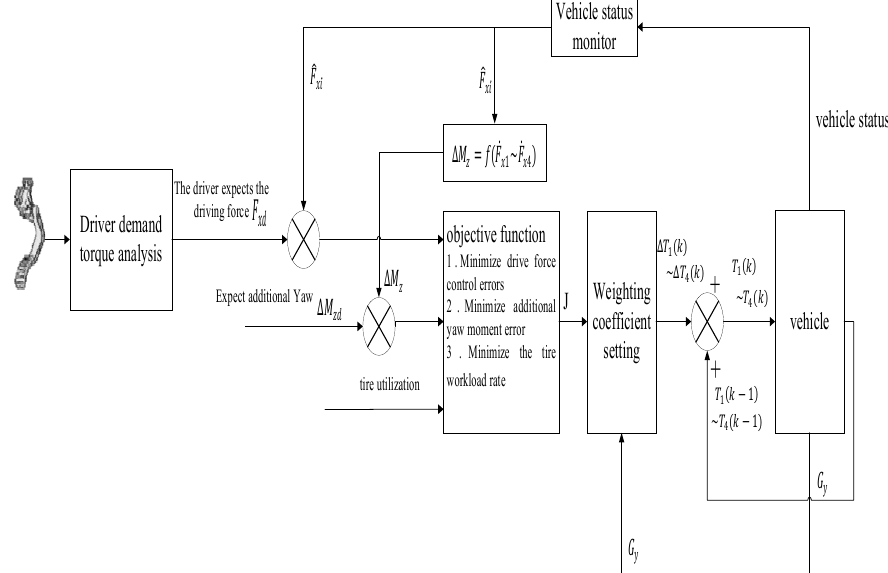
Figure 6. Optimal torque distribution strategy architecture.